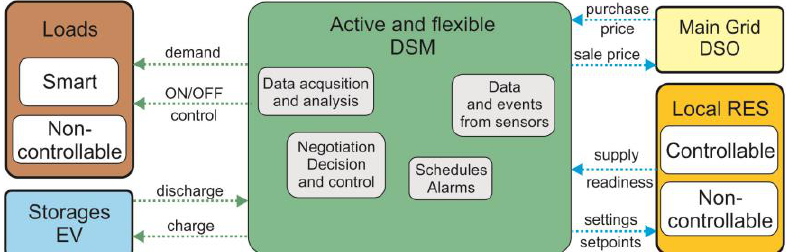
Figure 3. Data flows and processing in the active DSM with a negotiation mechanism dedicated for a prosumer microgrid.